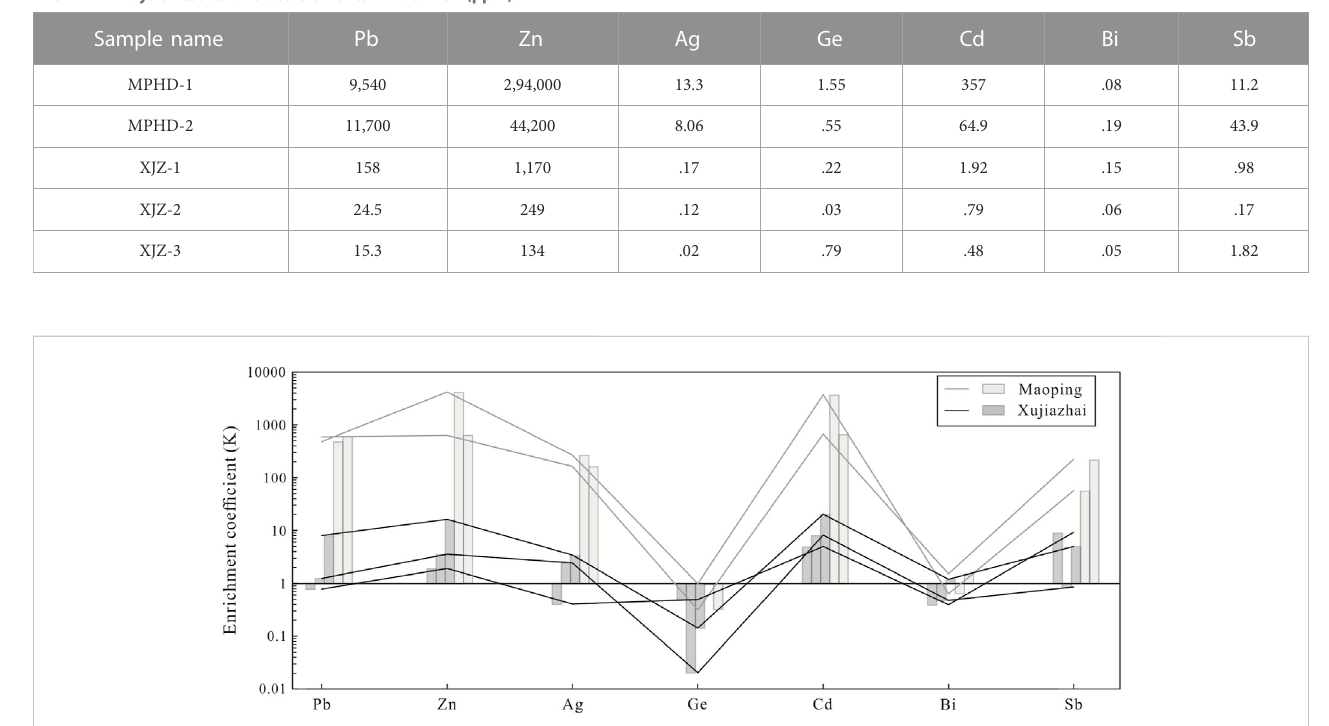
TABLE 2 Analysis results of trace elements in bitumen (ppm).